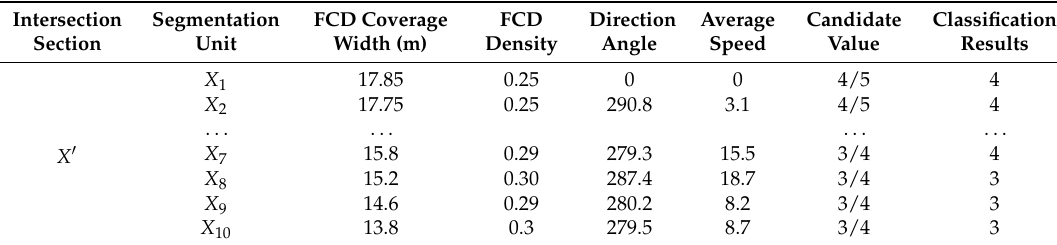
Table 4. Ultimate results for the objective road (intersection